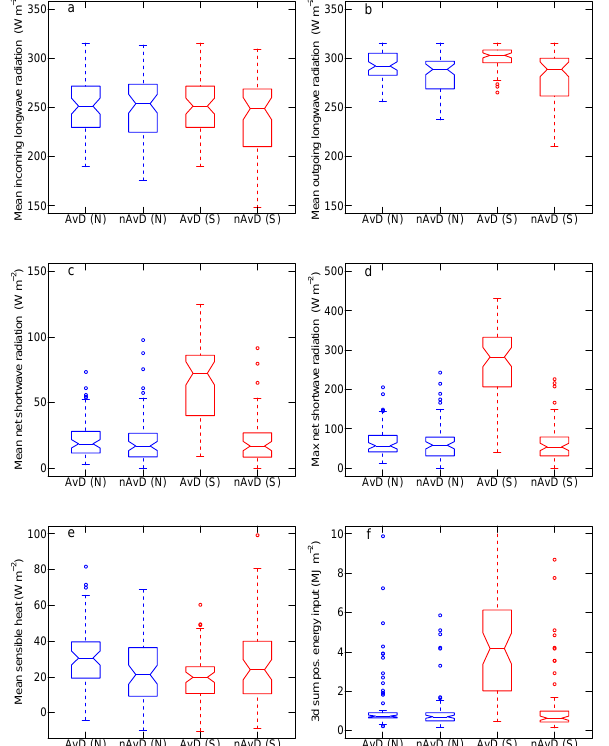
Fig. 7. Distribution of (a) mean incoming longwave radiation, (b) mean outgoing longwave radiation (c) mean net shortwave radi- ation, (d) max net shortwave radiation (e) mean sensible flux, and (f) the resulting 3-day sum of positive energy balance values for avalanche days (AvD) and non-avalanche days (nAvD) on south- facing (red) and north-facing (blue) slopes. Values were calculated with SNOWPACK assuming an elevation of 2500m and a slope an- gle of 35 ◦ .